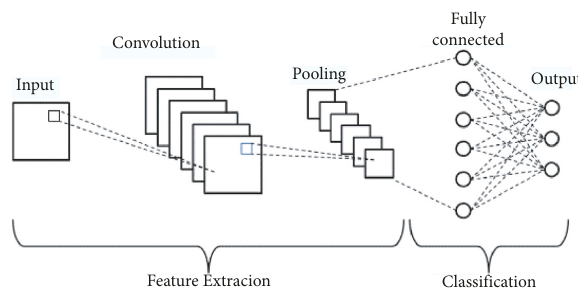
Figure 1: CNN basic